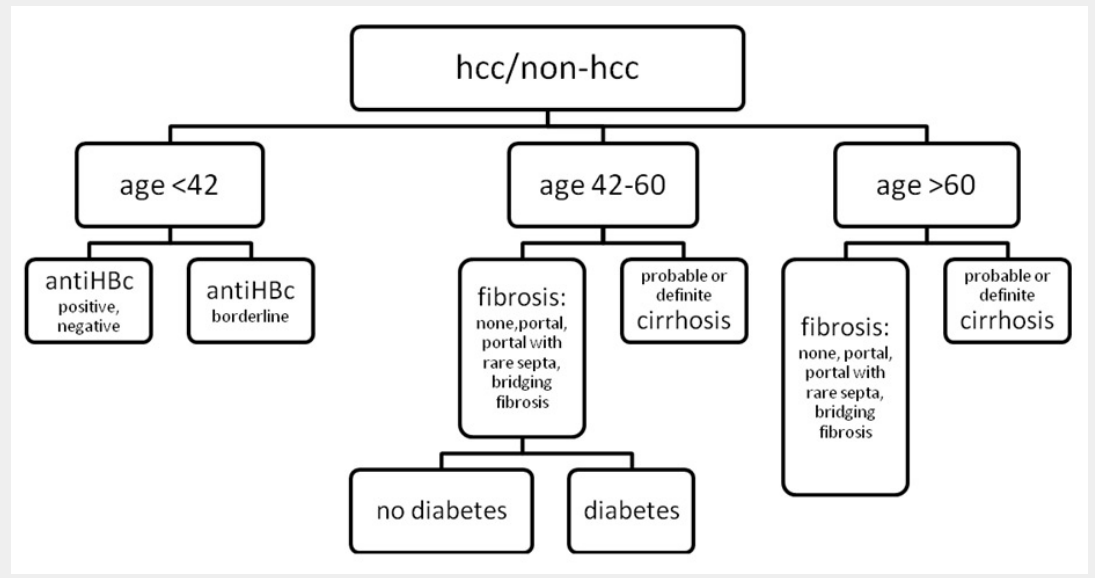
Figure 4 Hierarchial tree of important risk factors. Data for each level (left out of graph to conserve comprehensibility): level 1 (hcc/non-hcc): nonhcc = 96.2% (3,260), hcc = 3.8% (130); level 2 (age<42): non-hcc = 98.9% (1,639), hcc = 1.1% (19); level 2 (age 42–60): non-hcc = 95.5% (1,337), hcc = 4.5% (63); level 2 (age>60): non-hcc = 85.5% (284), hcc = 14.5% (48); level 3 (anti-HBcpos/neg): non-hcc = 99.1% (1,570), hcc = 0.9% (14); level 3 (anti-HBc borderline): non-hcc = 93.2% (69), hcc = 6.8% (5); level 3(fibrosis: none.): non-hcc = 96.9% (1,099), hcc = 3.1% (35), level 3 (cirrhosis):non-hcc = 89.5% (238), hcc = 10.5% (28), level3 (fibrosis: none) non-hcc = 92% (231), hcc = 8% (20); level 3(cirrhosis): non- hcc = 65.4% (53), hcc = 34.6% (28); level 4 (no diabetes): non-hcc = 97.3% (1,016), hcc = 2.7% (28), level 4 (diabetes): non-hcc = 92.2% (83), hcc = 7.8%